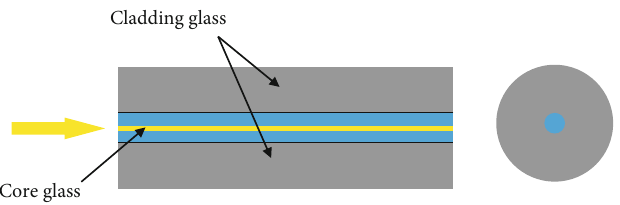
Figure 1: A schematic diagram of a single-mode fi ber optics.